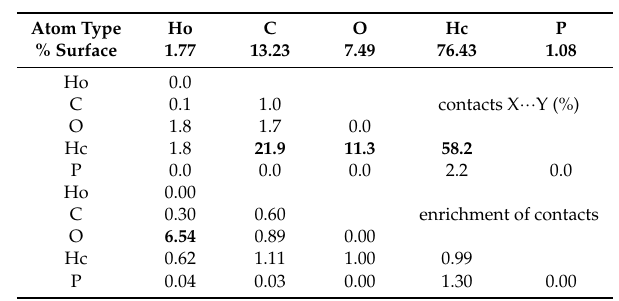
Figure 1. View of the molecular structure of compound 8a ( E -isomer). The thermal ellipsoids are shown at 50% probability level. Table 1. Chemical proportions S x on the Hirshfeld surface around the molecule in the crystal structure and decomposition of intermolecular contacts in pairs of atom types C xy . The enrichment values E xy are the ratios between C xy , the actual contact surfaces and those R xy computed as if all contacts were randomly distributed [30]. R xy equiprobable contacts are computed from S x values using probability laws. The Hirshfeld surface analysis was carried out with MoProViewer software [31]. The hydroxyl hydrogen atom Ho was distinguished from the hydrophobic Hc atoms. The majors contact types and the most enriched are highlighted in bold characters.